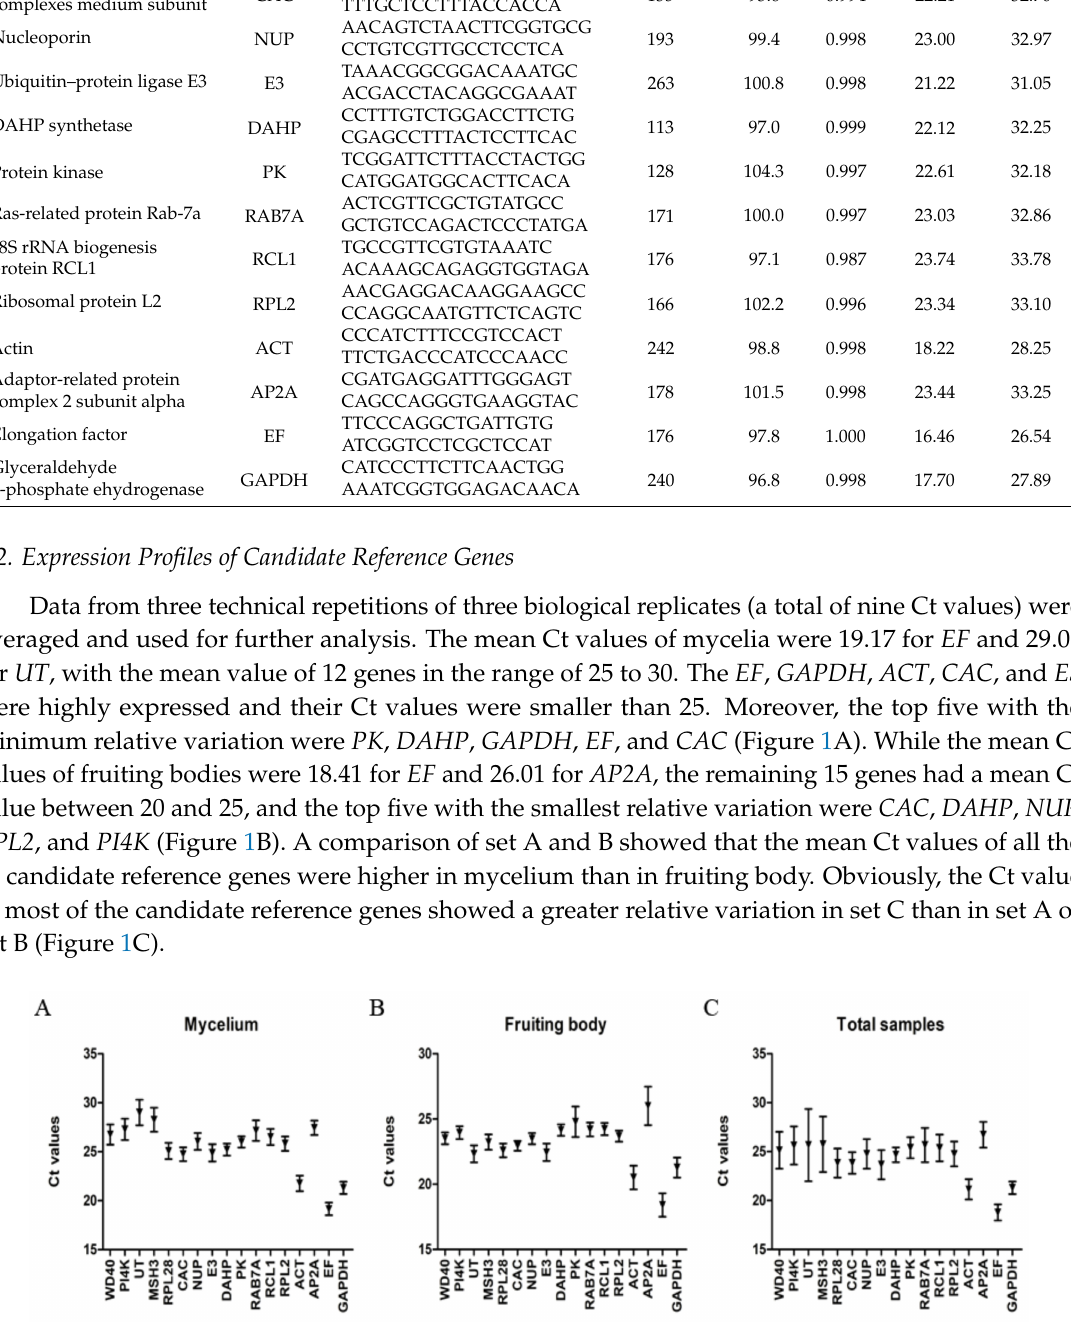
Figure 1. Variation in qRT-PCR values of candidate reference